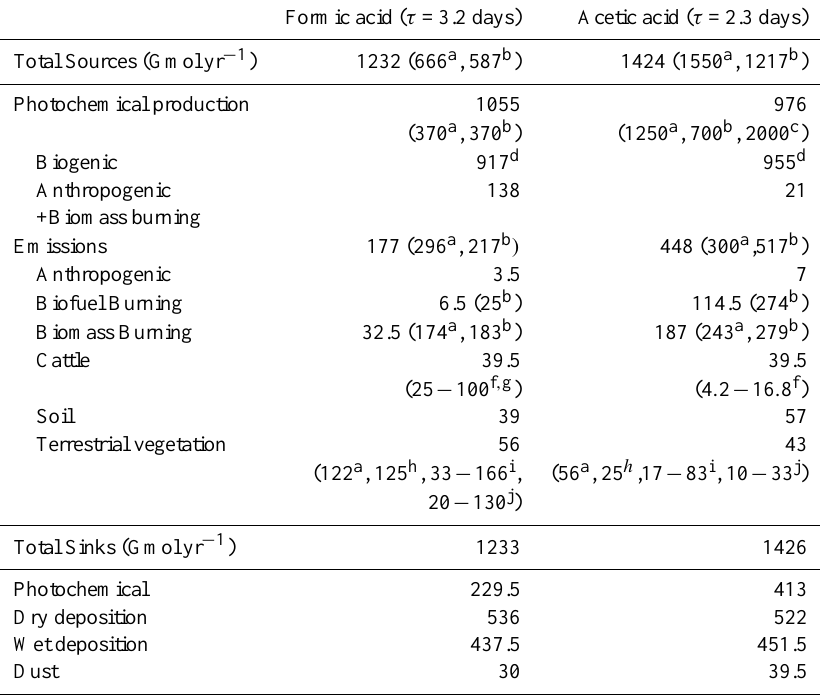
Table 3. Modeled global budget of atmospheric formic and acetic acids (2004–2008 average). Previous estimates are indicated in